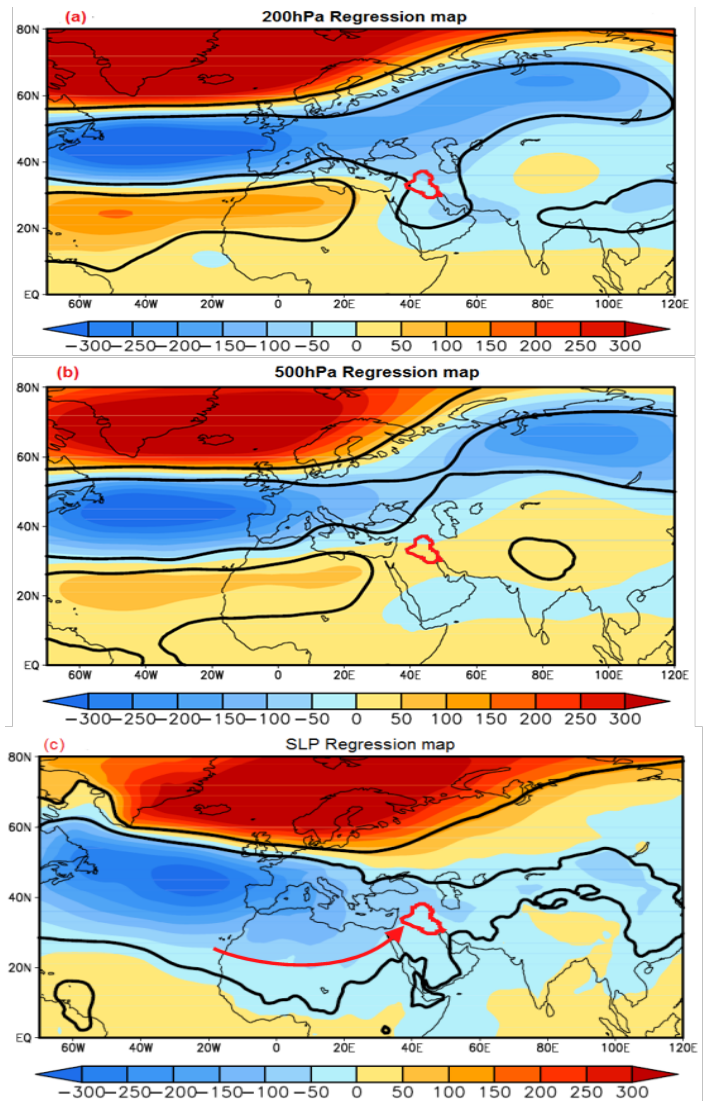
Figure5. Regression maps of winter (a) geopotential height 200hPa, (b) 500hPa and (c) SLP fields on the time series of North Atlantic SLP associated to the first pair derived through CCA (Fig4b), for the 1979 – 2009 period. The red contour lines in panels (a, b and c) mark the border of Iraq. The thick red arrow in panel (c) is used to explain the air advection. The black contour lines in panels (a, b and c) represent the 95% confidence level of the statistical significance of the regression.